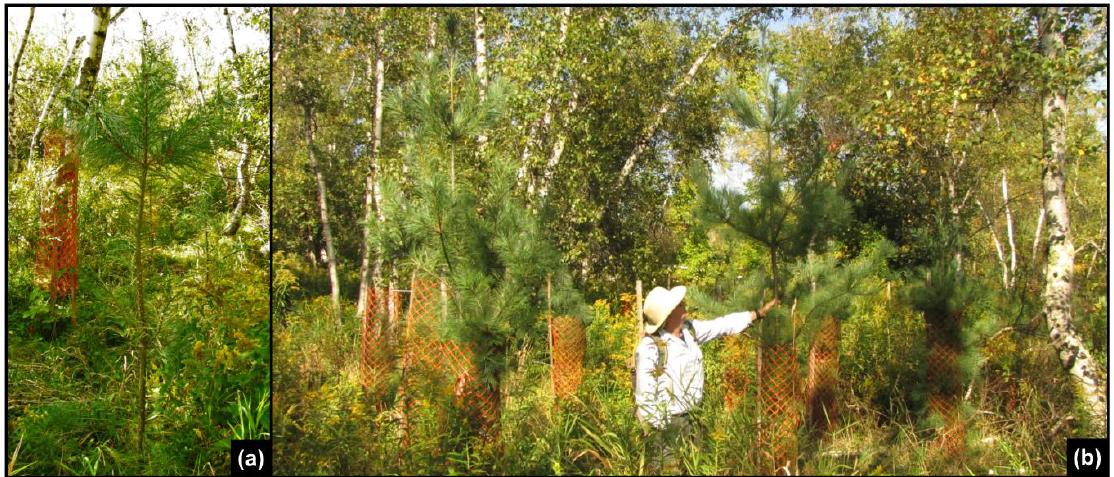
Figure 9. ( a ) Heavy browsing on white pine lateral branches in the control treatment. ( b ) White